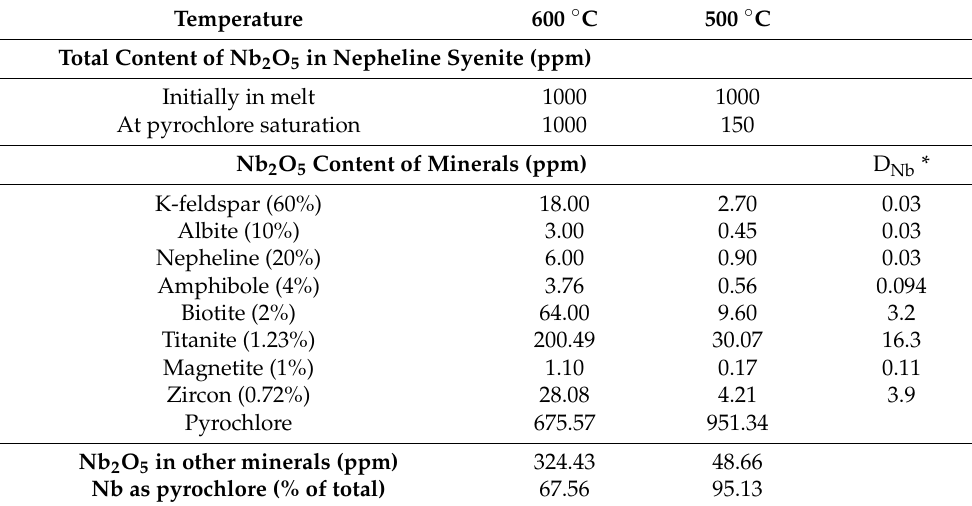
Table 4. The concentration of Nb in minerals of the Shuangshan nepheline syenite.